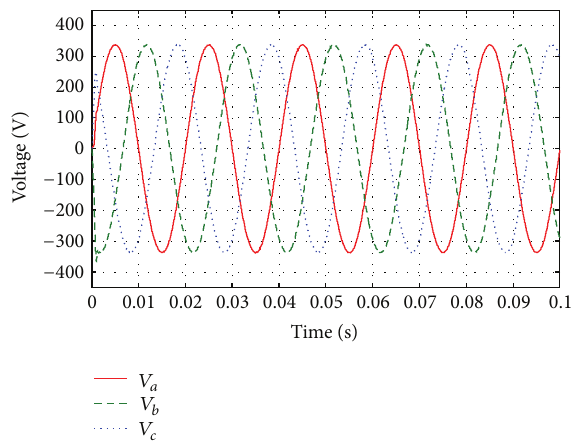
Figure 12: Output voltage waveforms (i.e., 𝑉 𝑎 , 𝑉 𝑏 , and 𝑉 𝑐 ) of the three-phase inverter with 𝑅 load.